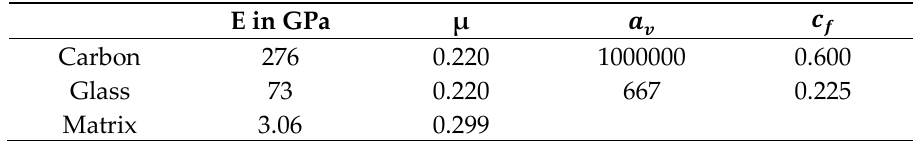
Table A1. Parameter of the Mori-Tanaka homogenization. E: Young’s modulus, μ: Poisson’s ratio, (cid:1853) (cid:3049) : aspect ratio, (cid:1855) (cid:3033) : fiber volume fraction. E in GPa μ (cid:2183)